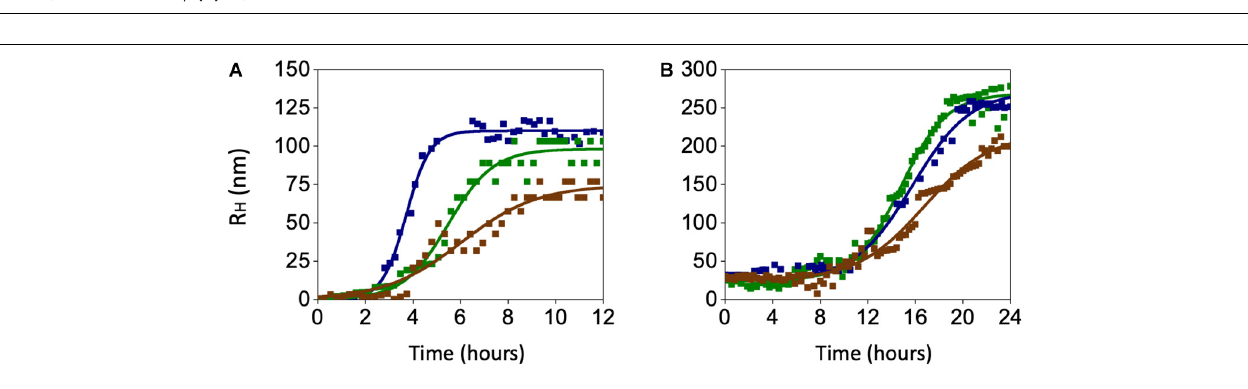
FIGURE 10 | Effects of carbon monoxide donor CORM-2 and bilirubin (BR) on the kinetics of A β aggregation. (A) A representative aggregation kinetics, measured by DLS, of 25 nM sA β (blu squares) in the presence of 50 nM CORM-2 (green squares) or 50 nM BR (red squares) is reported. (B) A representative aggregation kinetics, measured by DLS, of 6.25 nM fA β (blu squares) in the presence of 50 nM CORM-2 (green squares) or 50 nM BR (red squares) is reported (see section “Materials and Methods” for further